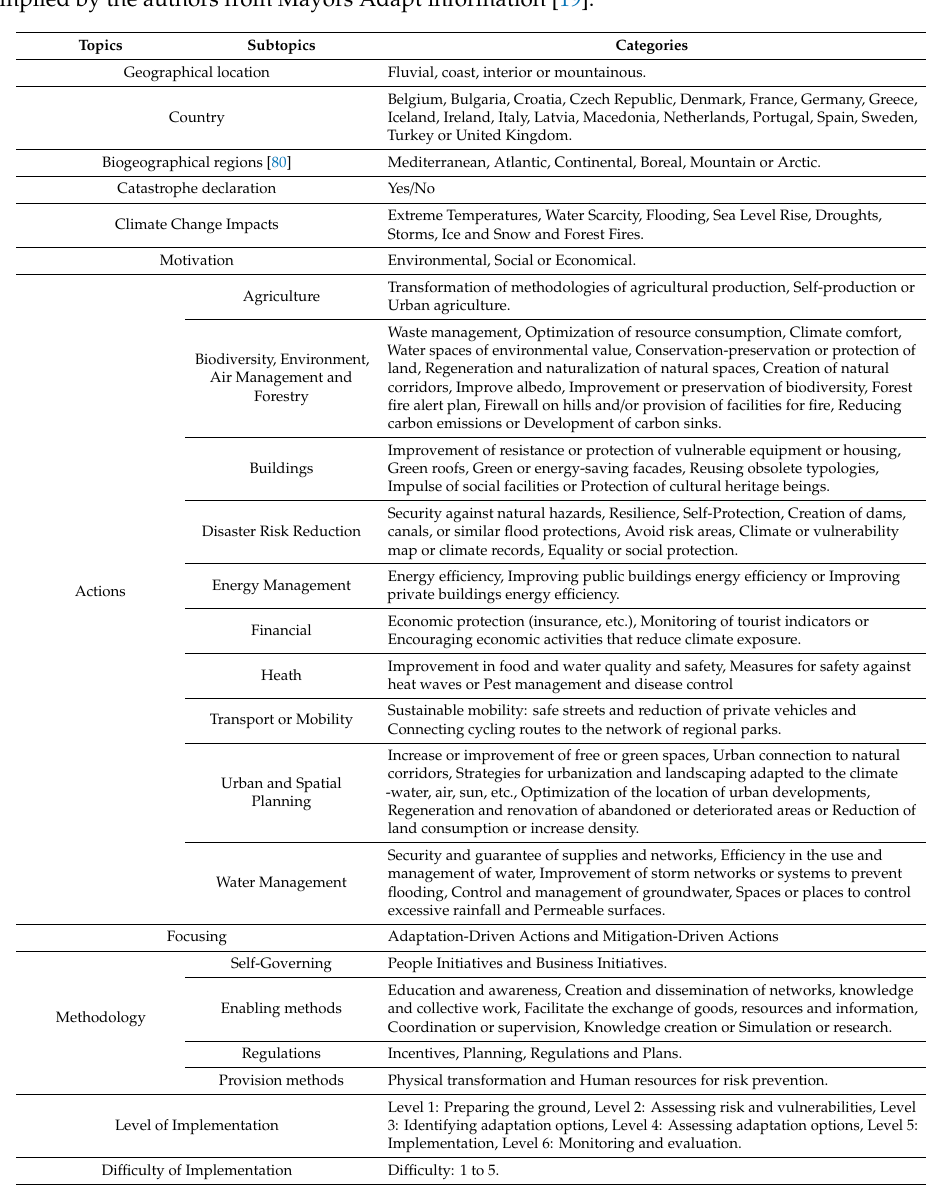
Table 1. Available and / or coded data for each “good practice” of the Mayors Adapt initiative. Source: Compiled by the authors from Mayors Adapt information